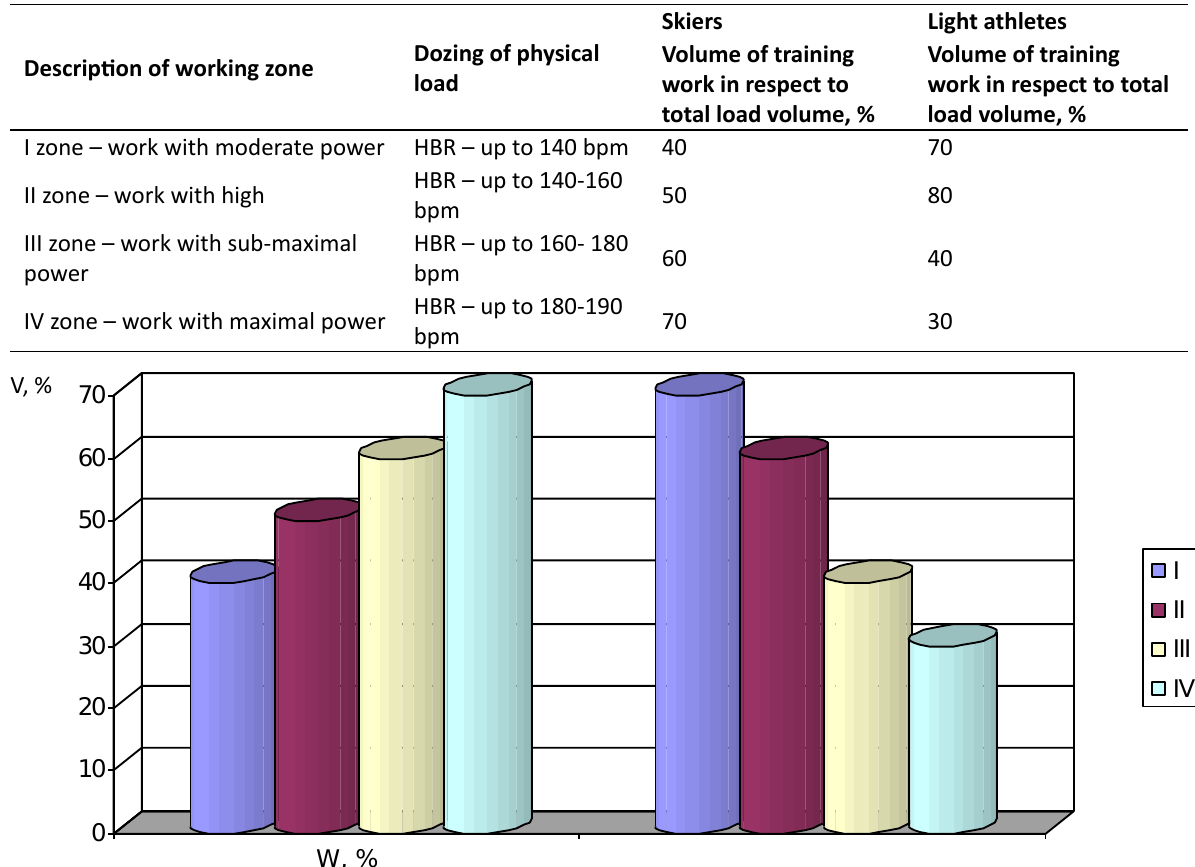
Table 3. Combined table of physical load’s distribution in annual training plan of skiers and light athletes